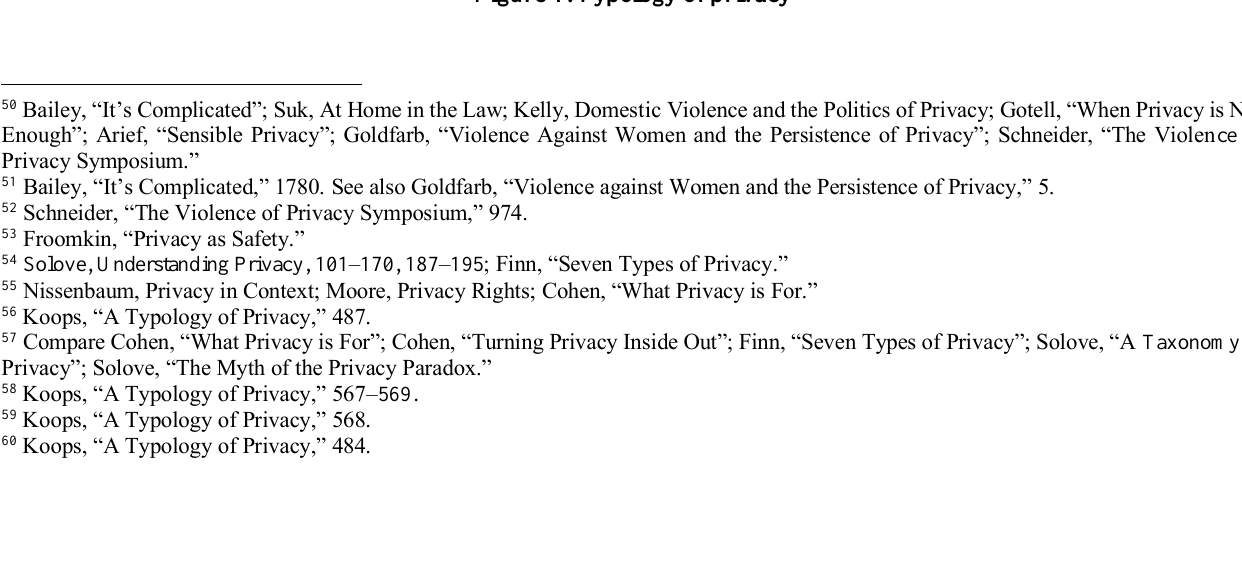
Figure 1. Typology of